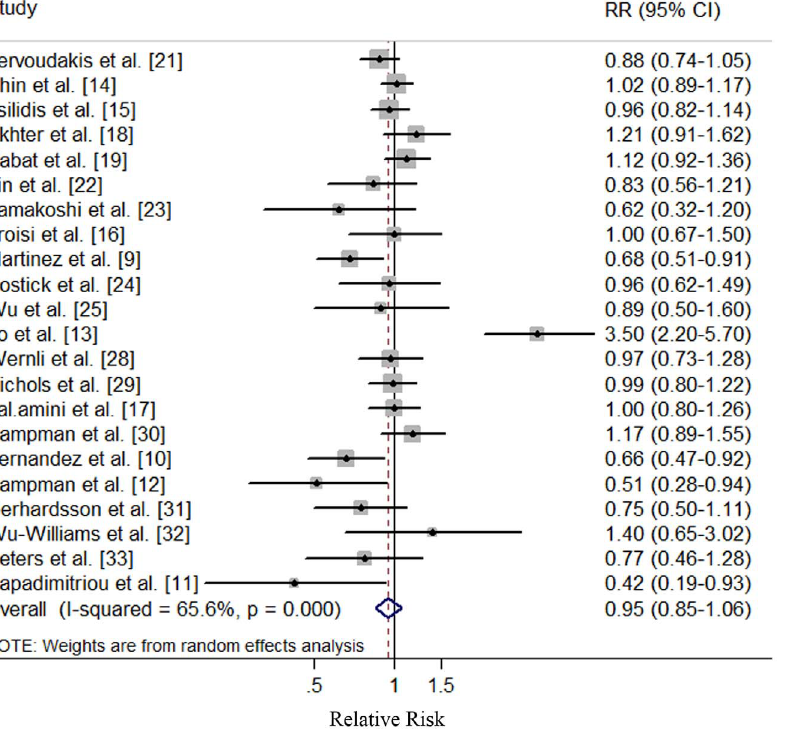
Figure 2. Forest plot (random effects model) of menarcheal age and colorectal cancer risk in overall studies. Squares indicate study- specific relative risks (size of the square reflects the study-specific statistical weight); horizontal lines indicate 95% CIs; diamond indicates the summary relative risk estimate with its 95% CI. CI: confidence interval; RR: relative risk.